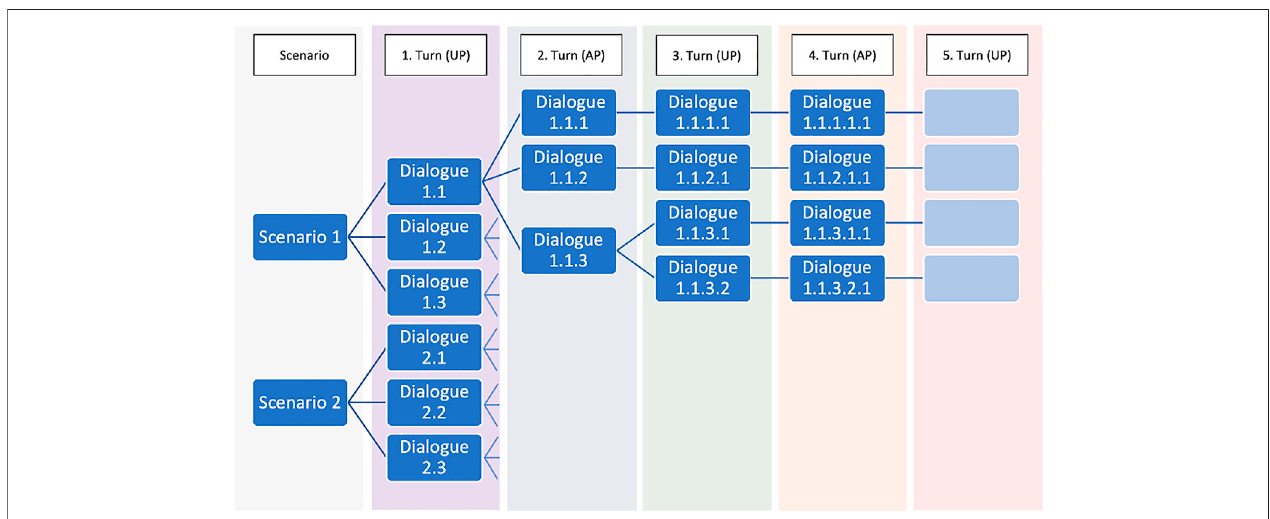
FIGURE 6 | One-to-many ratio showing how one dialogue seed was used to elicit multiple dialogue